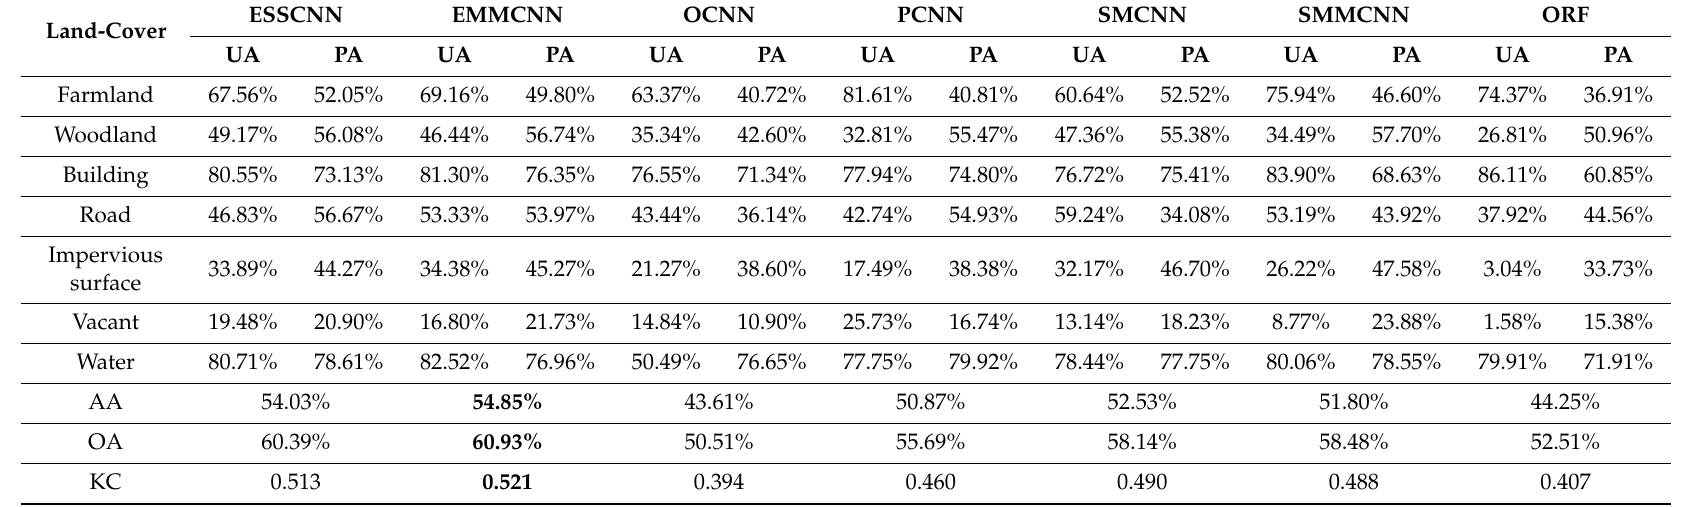
Table 13. Classification accuracy comparison amongst ESSCNN, EMMCNN, OCNN, PCNN, SMCNN, SMMCNN, and ORF methods for the Yuecheng validating